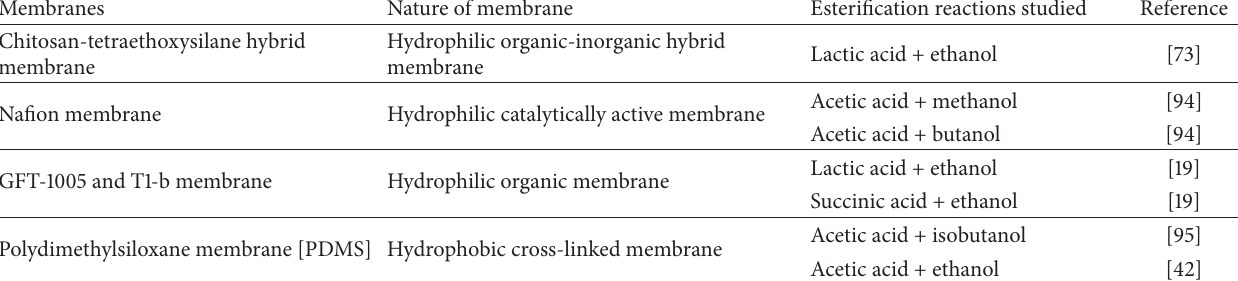
Table 1: Pervaporation membranes employed for various esterification